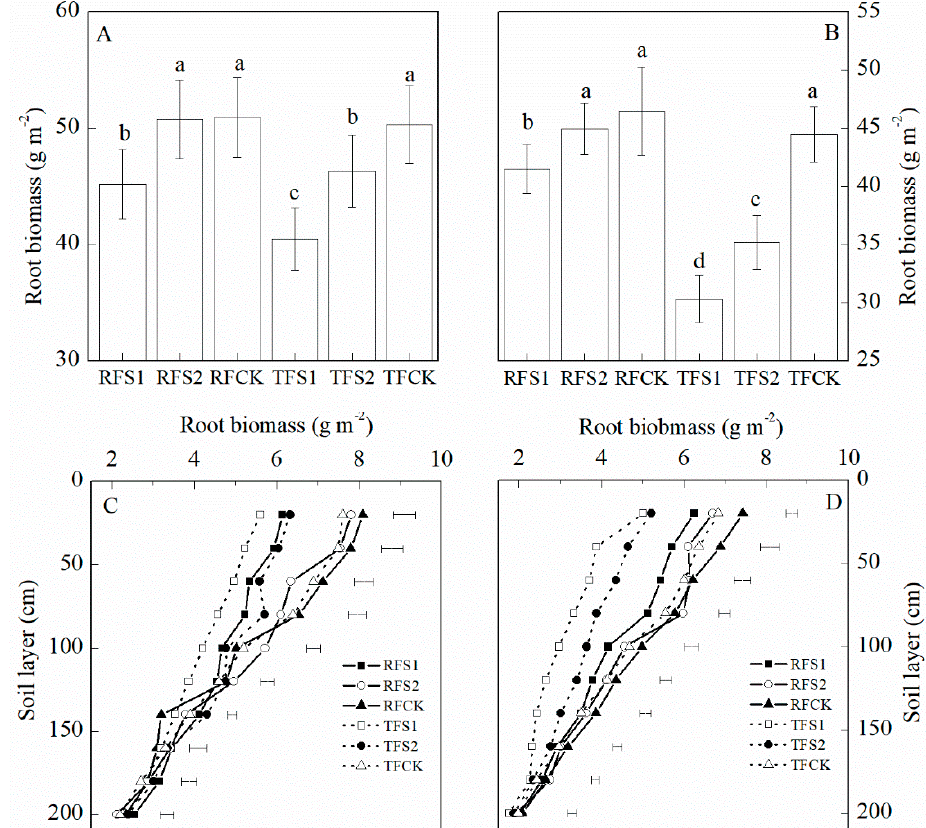
Figure 5. Effects of planting and irrigation on the root biomass at the stage of maturity. ( A , B ) The total root biomass under 0–200 cm soil layer, in 2016–2017 and 2017–2018, respectively. ( C , D ) The root biomass in 20 cm increments in the 0–200 cm soil layer, in 2016–2017 and 2017–2018, respectively. In ( A ) and ( B ), vertical bars represent ± the standard deviation of the mean ( n = 3). Values followed by different letters are significantly different at p = 0.05. In ( C ) and ( D ), horizontal bars represent the honestly significant difference at p = 0.05. RF: plastic-covered ridge and furrow planting; TF: traditional flatten planting; S1: supplemental irrigation based on measuring soil moisture and the target relative soil water content is 85%; S2: supplemental irrigation based on measuring soil moisture and the target relative soil water content is 100%; CK: traditional irrigation.